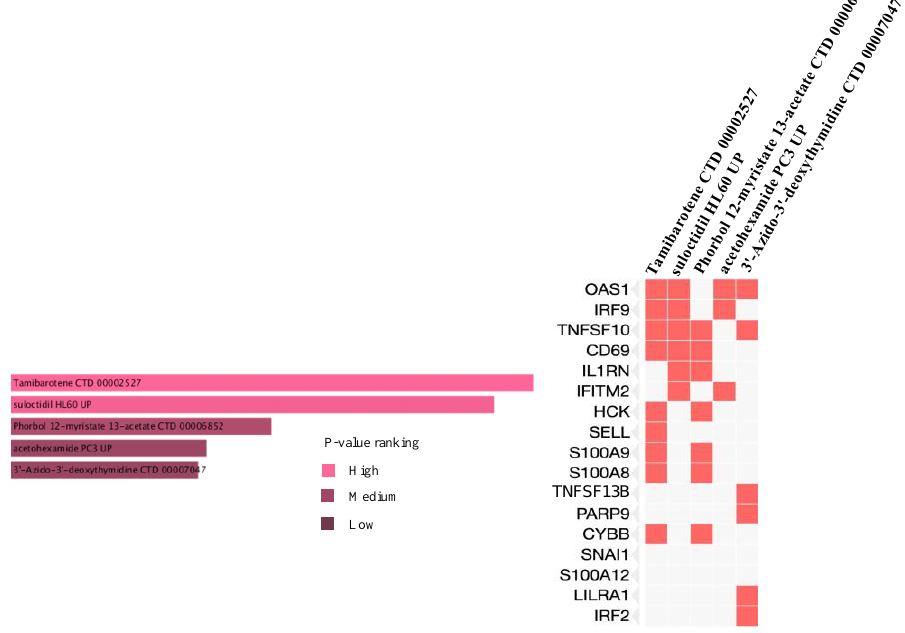
Figure 6. Prediction of drug candidate molecules. The drug candidate molecules were predicted by the DSigDB database of the Enrichr web platform. The results were based on the interaction of 22 common genes with drugs and sorted by adjusted P-values. Enriched genes were marked. Table 1. Suggested TOP 5 drug compounds.